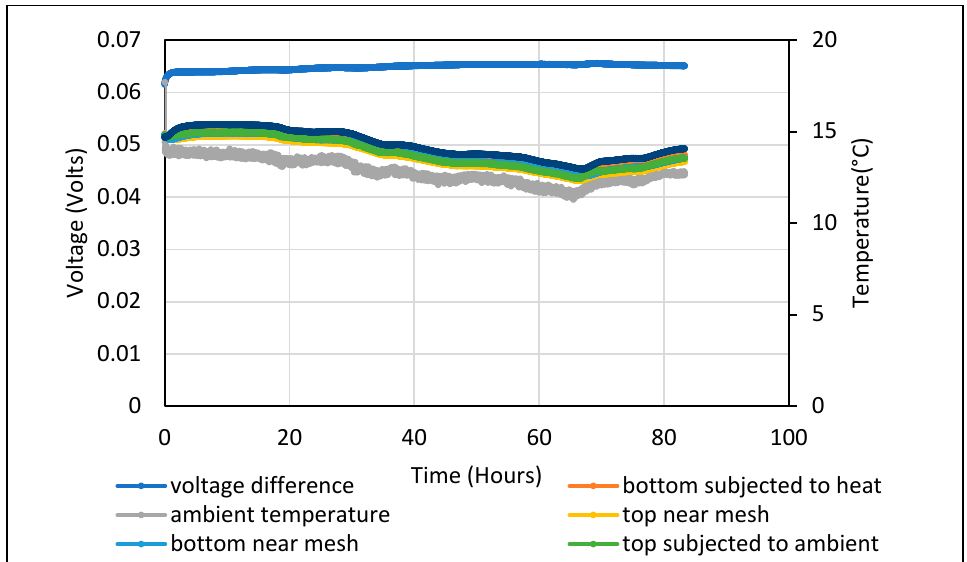
Figure 10. Potential difference obtained from a 5 wt.% Fe 2 O 3 cement composite at zero temperature gradient.